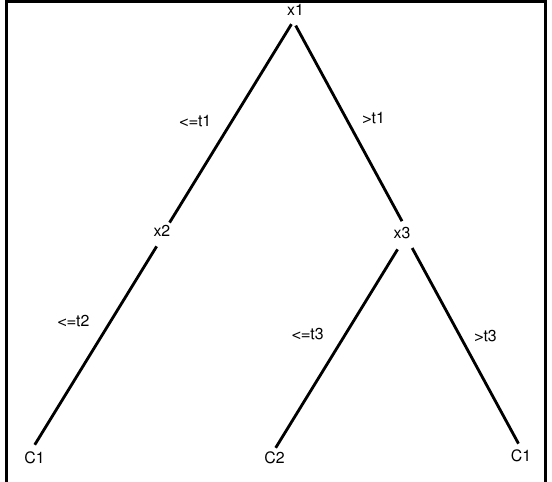
Figure 2. An example of a tree with two depth levels. Each path from the root to a leaf represents a propositional rule of two different classes ( C 1 and C 2